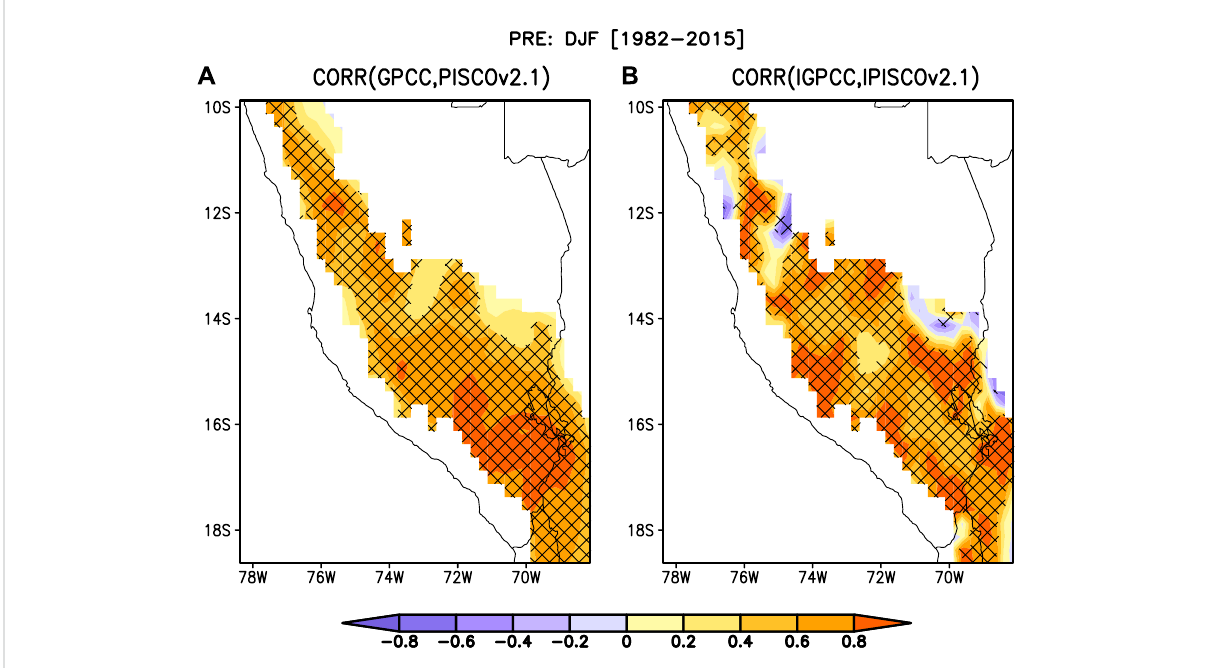
FIGURE 9 (A) Spatial correlation of the interannual DJF precipitation anomalies in the Central Andes above 1,500 m asl between GPCC and PISCO v2.1datasets during the1982 – 2015 period. (B) As in (A) but for theinterdecadal component. Hatching indicates regions with astatistically signi fi cant correlation at the 95% con fi dence